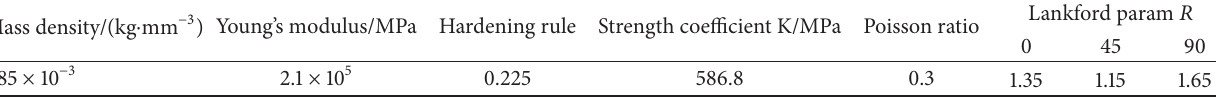
Table 1: Mechanical property parameters of WSS-M-1A365A12 steel sheet.